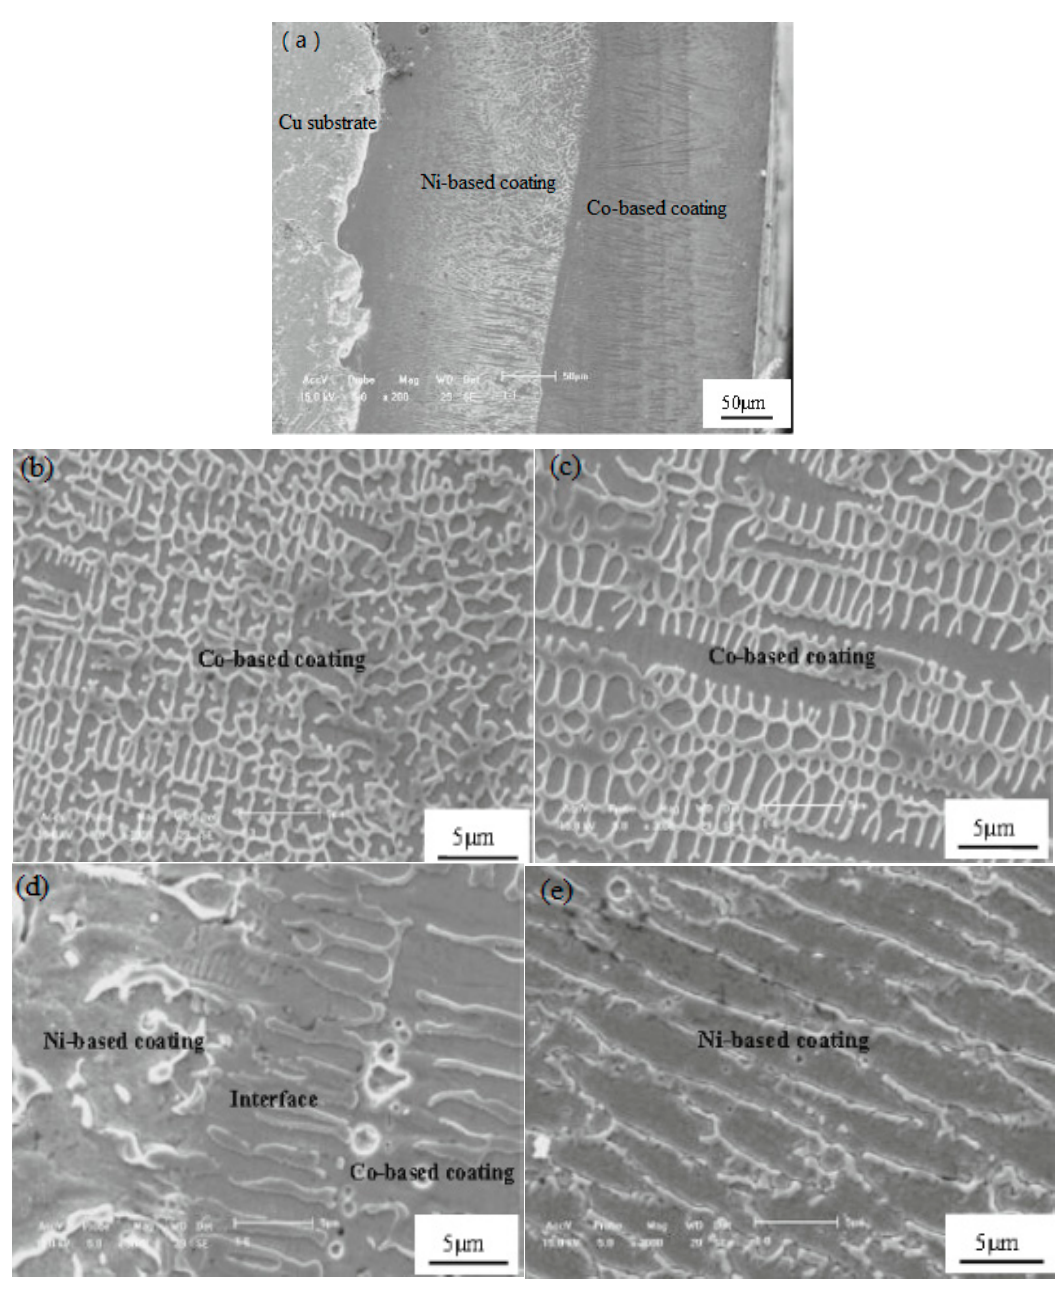
Figure 6. Cross ‐ sectional micrographs of the Ni–Co duplex coating: ( a ) microstructure of duplex coating; ( b )surface microstructure of Co ‐ based coating; ( c )middle microstructure of Co ‐ based coating; ( d )bottom microstructure of Co ‐ based coating and ( e ) Ni/Al 2 O 3 intermediate coating.